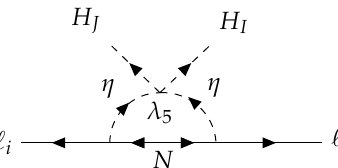
Figure 4. Radiative neutrino mass in the scotogenic model. The loop and λ 5 suppression allows for T e V − scale new physics and small neutrino masses.